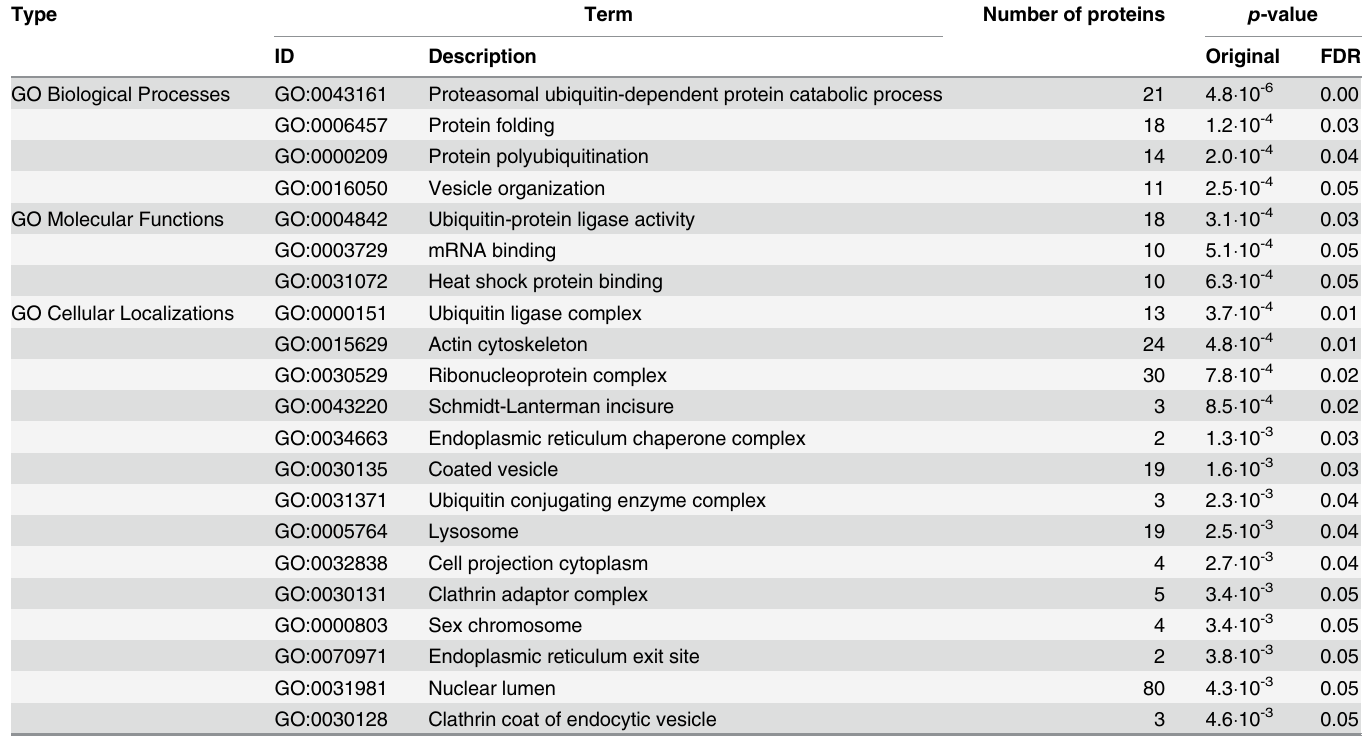
Table 2. Enrichment of Gene Ontology (GO) terms for human proteins interacting with B. mallei virulence factors. Type